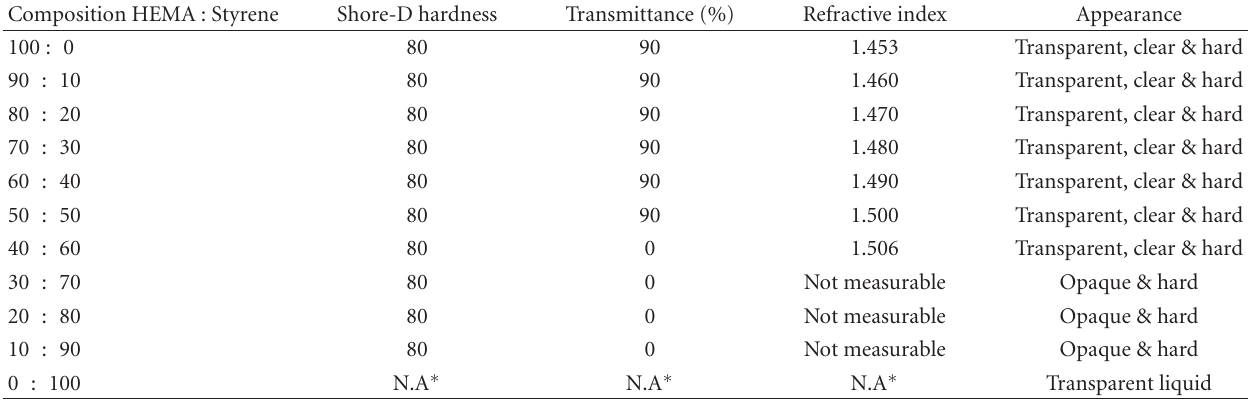
Table 5: Properties of polymers obtained with HEMA : Styrene by varying